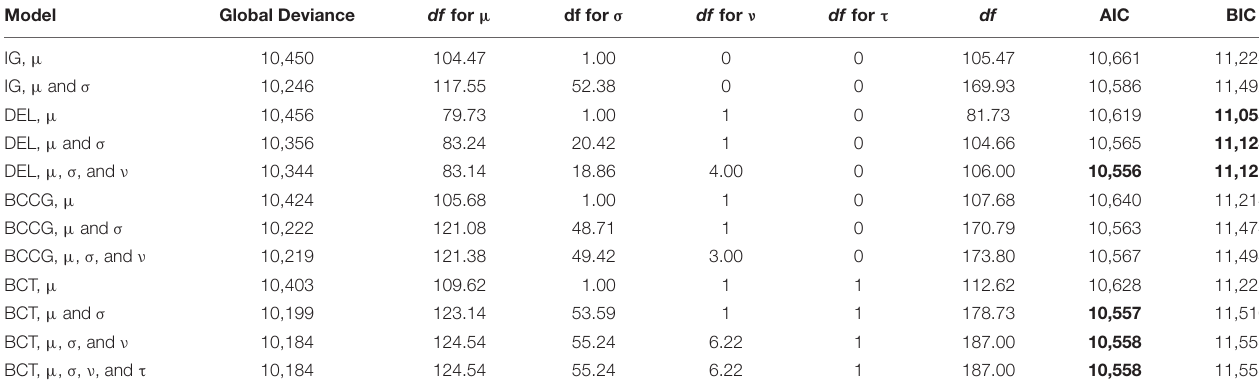
TABLE 5 | Comparisons of various GAMLSS models with different distributions and different levels of modeling of parameters. Model Global